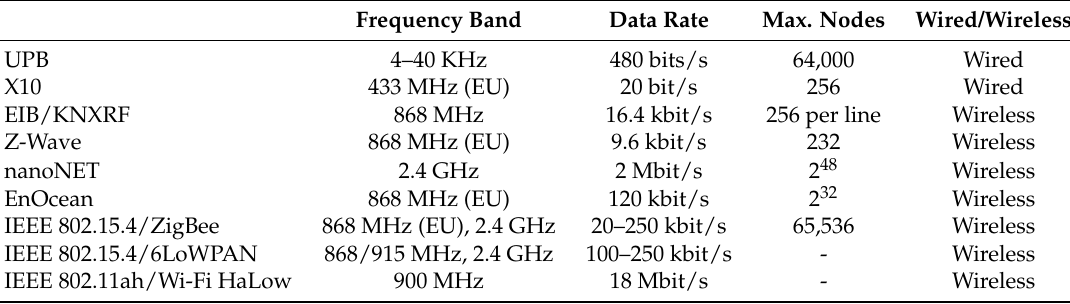
Table 1. Comparison of relevant home automation communication